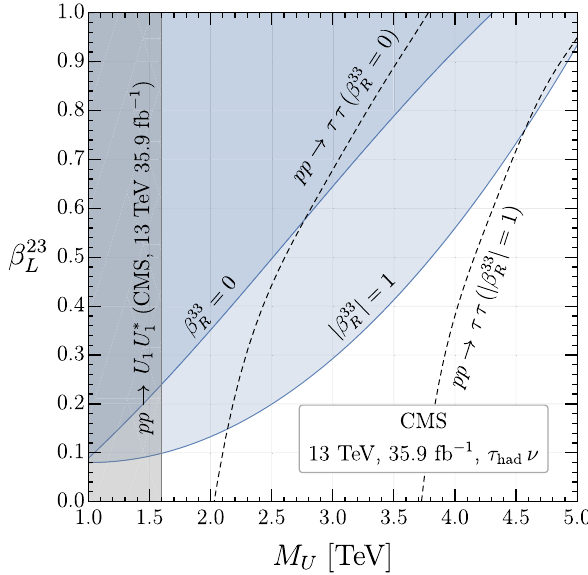
, M ) U L = 1, g = 3 . We fix β 33 U R L